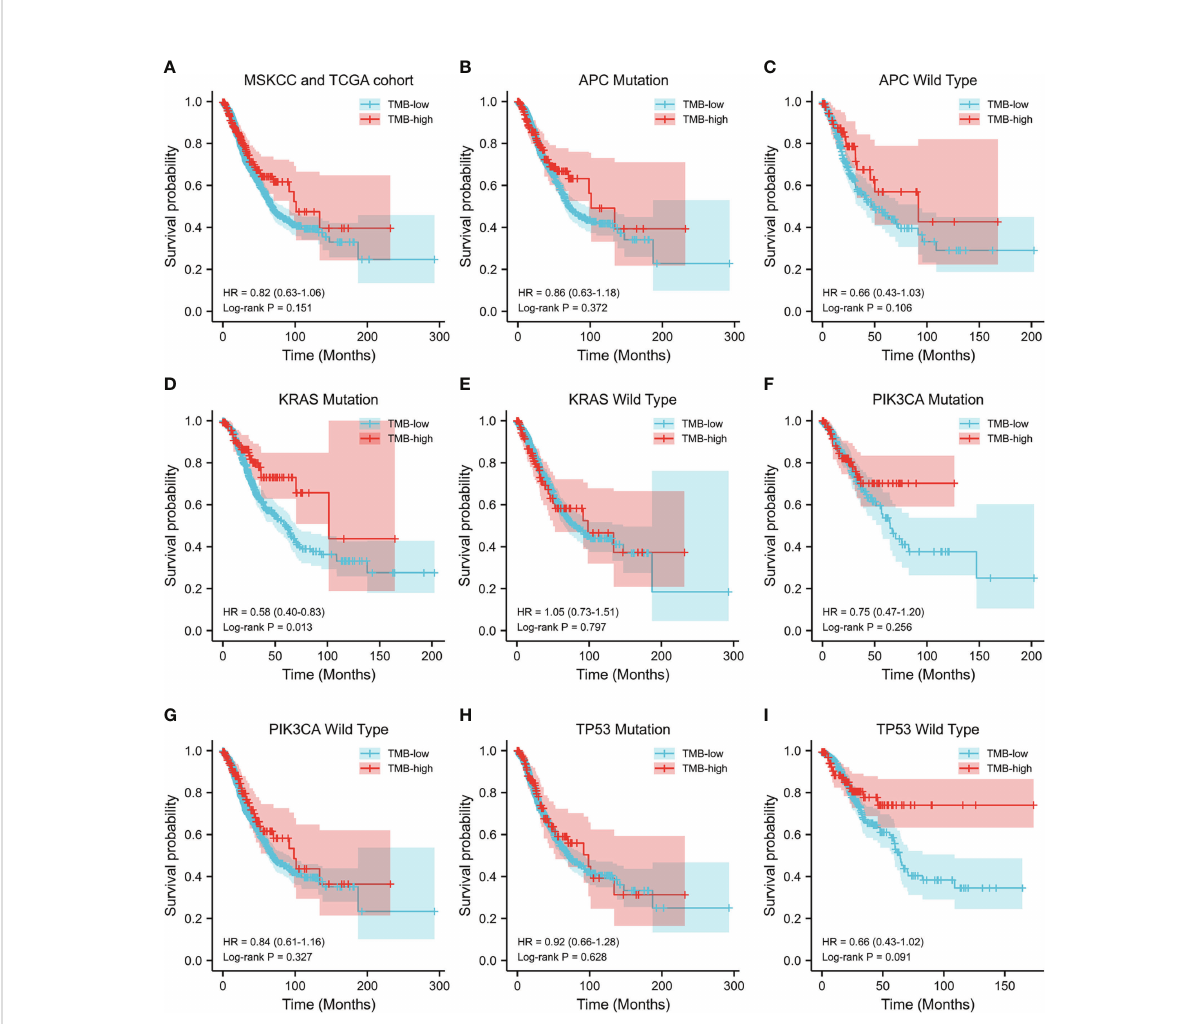
FIGURE 2 Evaluation of the tumor mutation burden (TMB) to predict the prognosis of patients with colorectal cancer (CRC). (A) Kaplan – Meier curve showing the impact of TMB on the overall survival (OS) of all CRC patients with complete TMB and OS data [1,652 patients from the Memorial Sloan Kettering Cancer Center (MSKCC) and The Cancer Genome Atlas (TCGA) cohorts] in this study (HR = 0.82, p = 0.151). (B – I) Kaplan – Meier analysis showing the impact of TMB on the OS of CRC patients with APC mutations (HR = 0.86, p = 0.372) (B) , wild-type APC (HR = 0.66, p = 0.106) (C) , KRAS mutations (HR = 0.58, p = 0.013) (D) , wild-type KRAS (HR = 1.05, p = 0.797) (E) , PIK3CA mutations (HR = 0.75, p = 0.256) (F) , wild-type PIK3CA (HR = 0.84, p = 0.327) (G) , TP53 mutations (HR = 0.92, p = 0.628) (H) , and wild-type TP53 (HR = 0.66, p = 0.091) (I) .